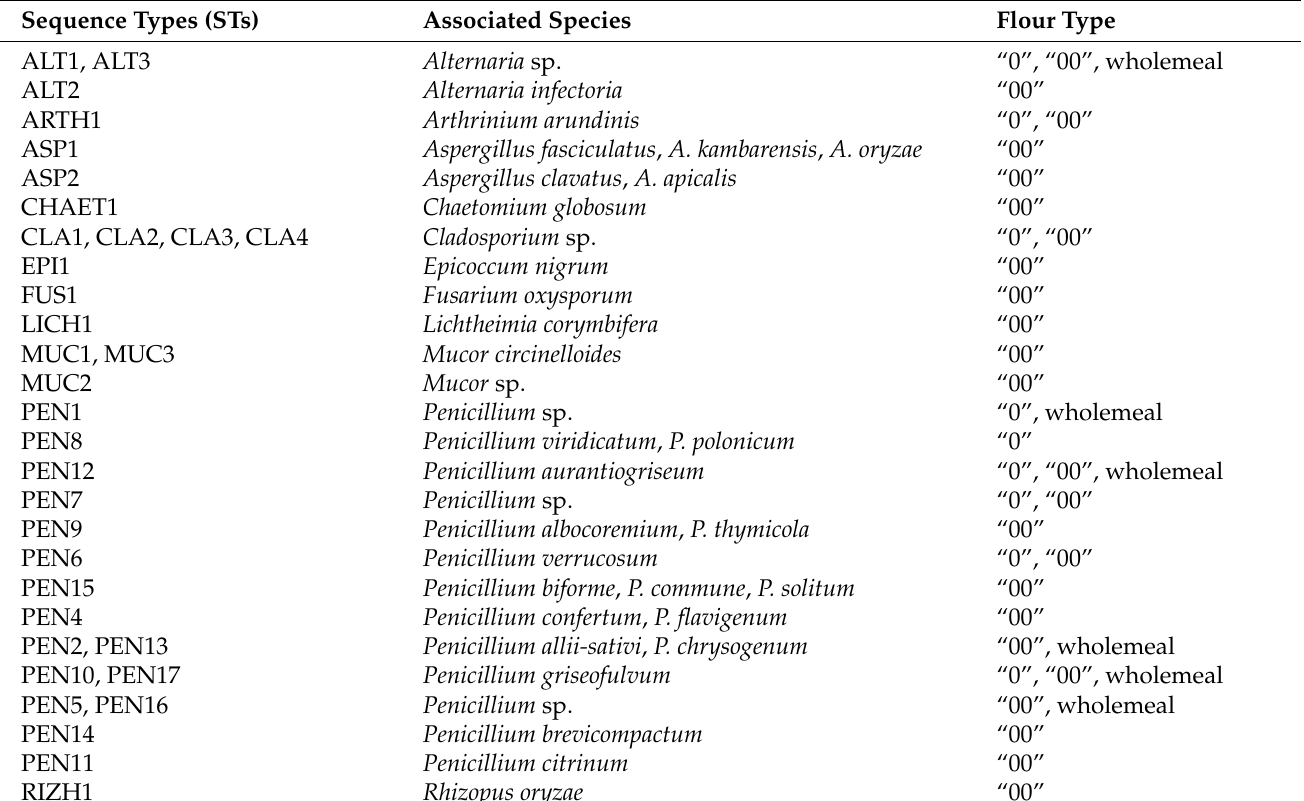
Table 1. List of sequence types (STs) detected in our flour samples (type “0”, “00” and wholemeal) using a conventional culturing method. Each ST is associated with one or more species according to results of phylogenetic